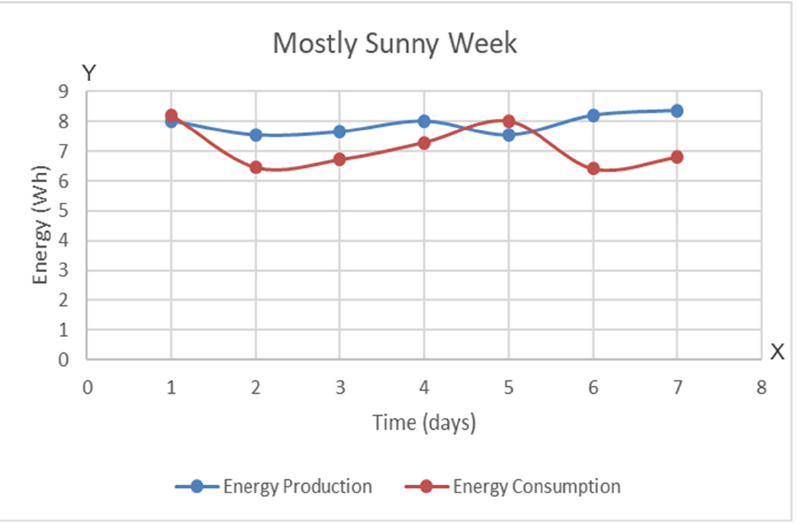
Figure 6. Modified Global Energy Production of the Solar Tracking Device using Reliability-Oriented Metrics for the Mostly Sunny Week.